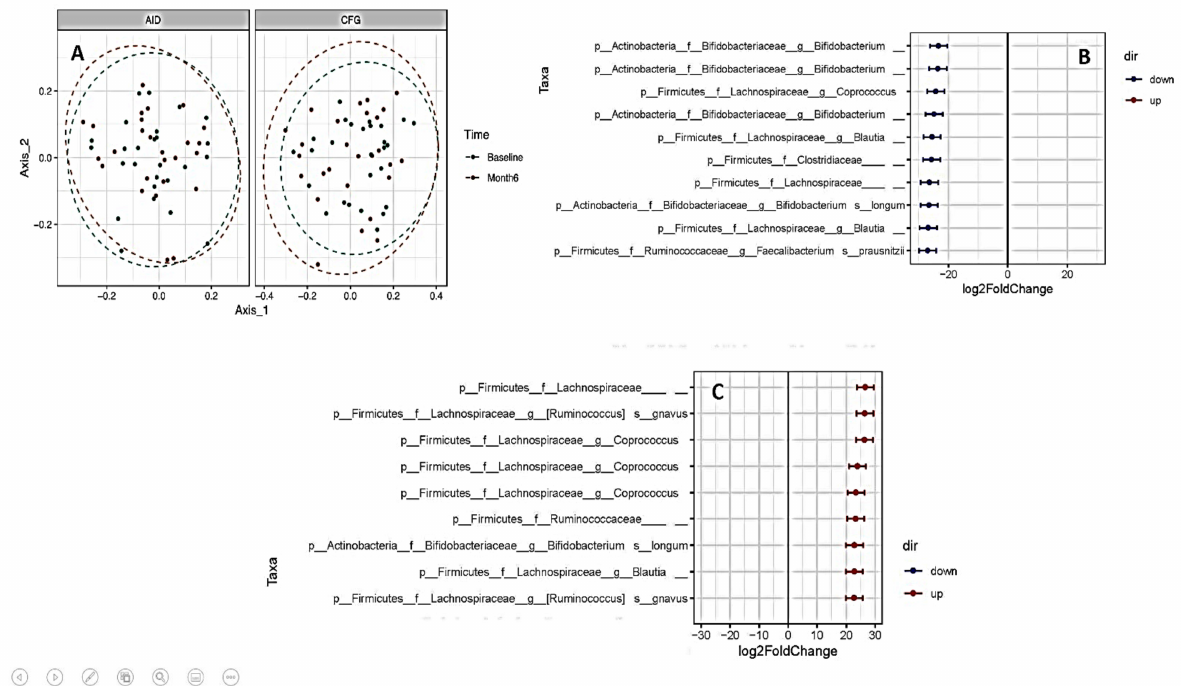
Figure 4. ( A ) Principal Coordinates Analysis (PCoA) plot of beta-diversity for bray distance matrix showing no significant changes in gut microbial composition in the Anti-inflammatory Diet (AID) and Canada’s Food Guide (CFG) groups from baseline to month 6 or time of clinical relapse. ( B ) Differen- tial abundance testing showing significant changes in several bacterial amplicon sequence variants (ASVs) from baseline to the end of the intervention in the Canada’s Food Guide diet group (adjusted p < 0.01, absolute fold change >5). ( C ) Differential abundance testing showing significant changes in several bacterial amplicon ASVs from baseline to the end of the intervention in the Anti-Inflammatory Diet group (adjusted p < 0.01, absolute fold change